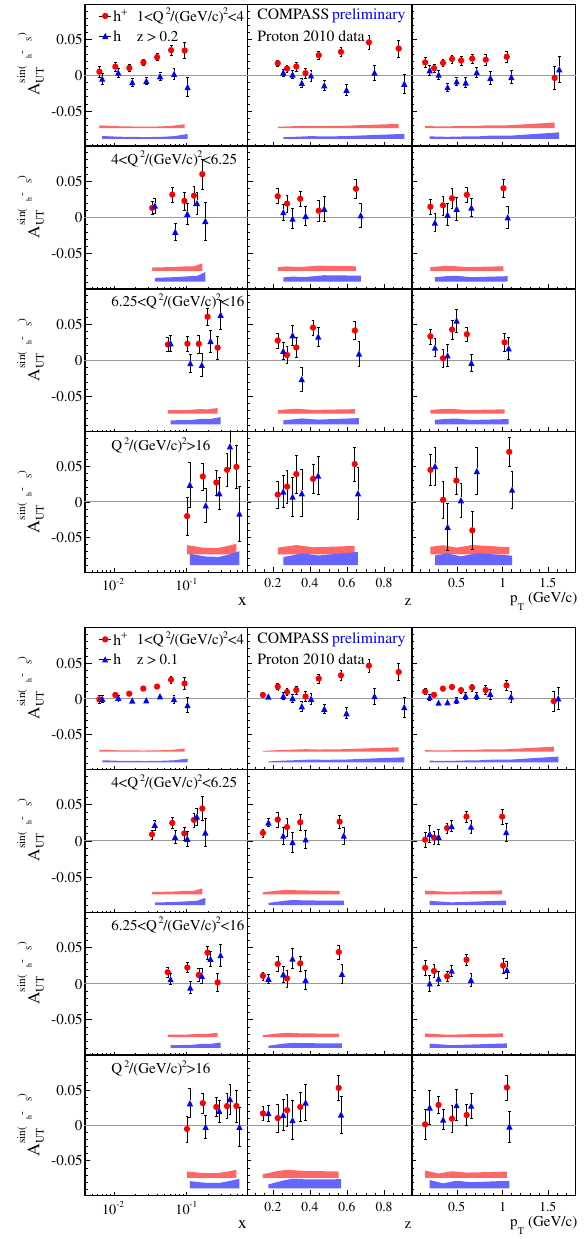
Figure 5. Sivers asymmetry: z > 0 . 2 (top), z > 0 . 1